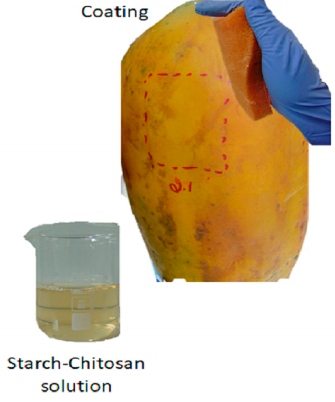
Figure 1. Coating application.